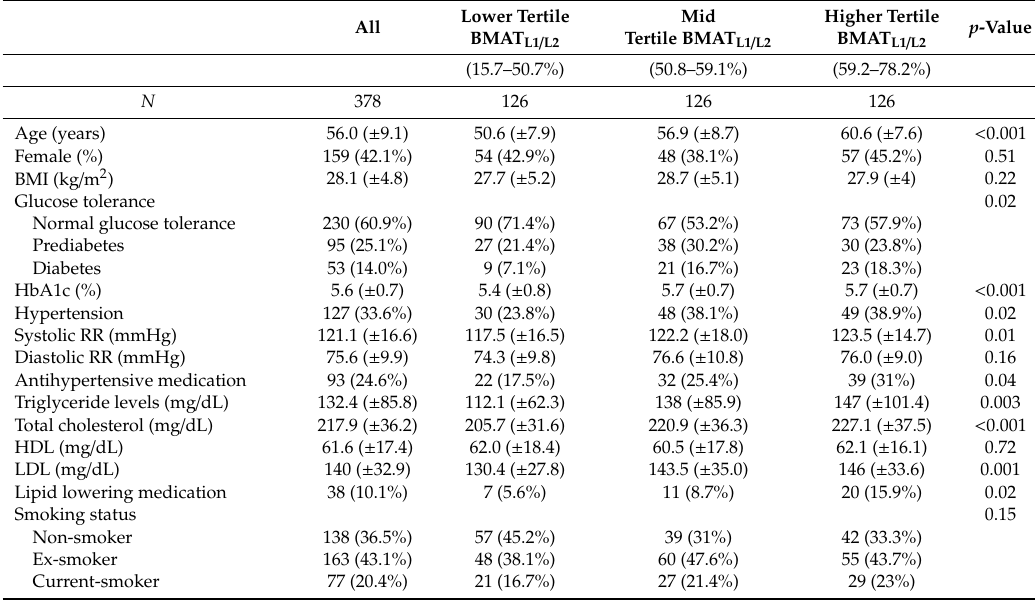
Table 1. Characteristics of the entire cohort